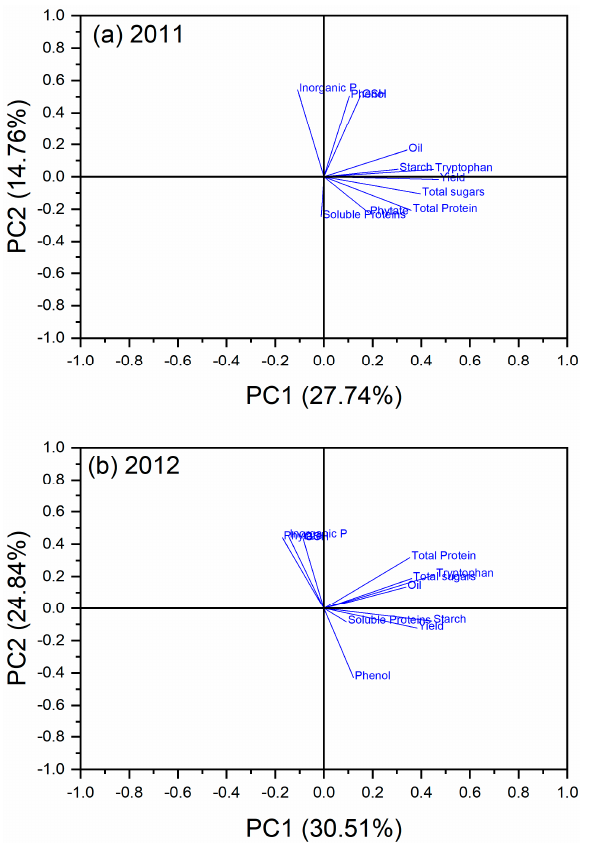
Figure 3. PCA loading plots of maize yield and grain quality parameters for the years 2011 and